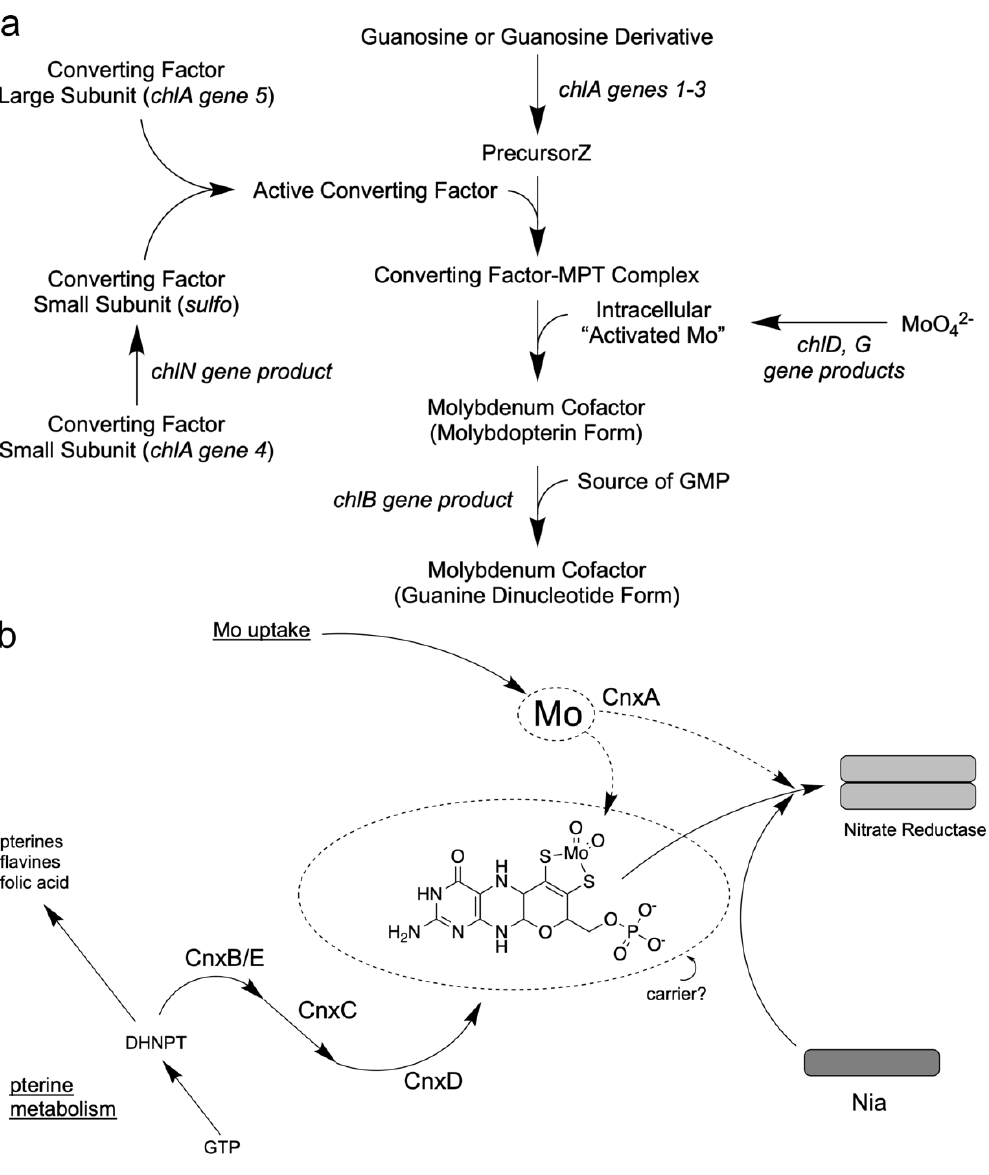
Figure 2. Models for the Moco biosynthesis pathway. ( a ) Model for the Moco biosynthesis pathway in E. coli , published by the Rajagopalan group in 1992. The proteins are named according to their functions. Modified after [81]. ( b ) Model for the Moco biosynthesis pathway in plants, published by Mendel in 1992 [84]. The proteins are named in the Cnx nomenclature. CnxA is the molybdate insertase. DHNPT stands for dihydro neopterin triphosphate. Nia is the designation for the nitrate reductase monomer. Modified after [84].